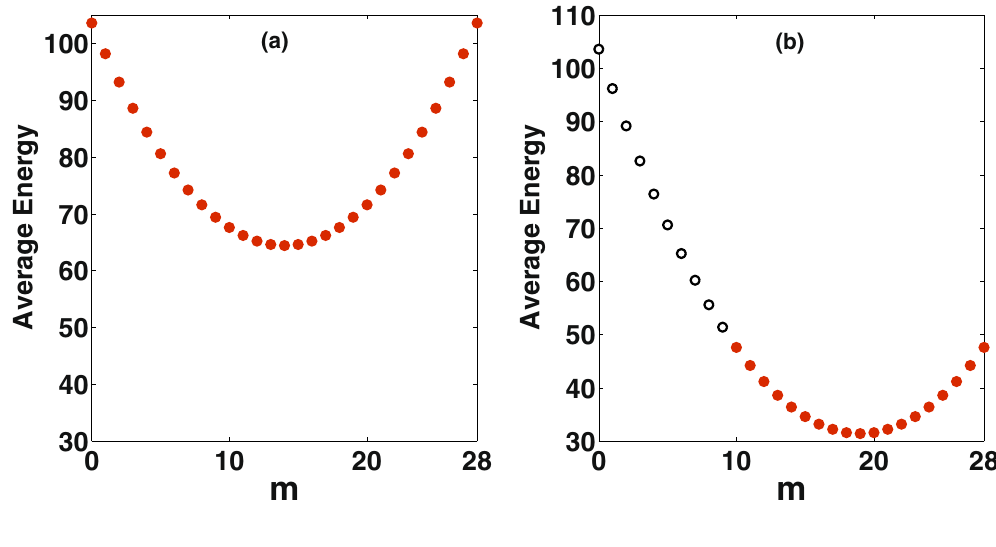
Figure 3. Average energy ′ m n H m n , , as a function of m , with Δ = 0, χ = 0.1 (Left) and Δ = − 2, χ = 0.1 A (Right). The system parameters are expressed in units of ω 1